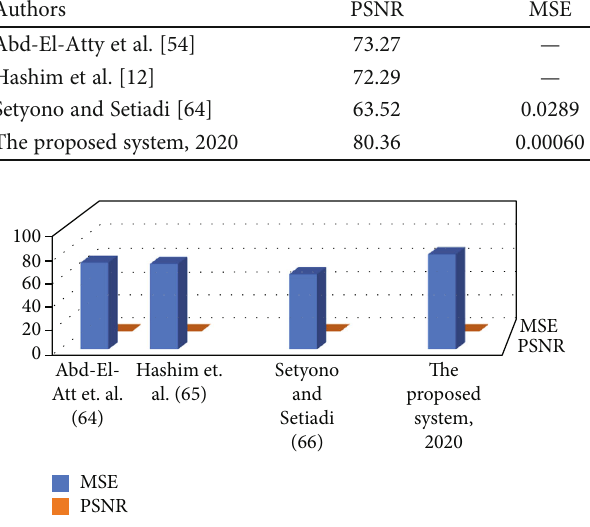
Figure 8: Comparative analysis with previous researches. Table 3: Parameter values of the proposed